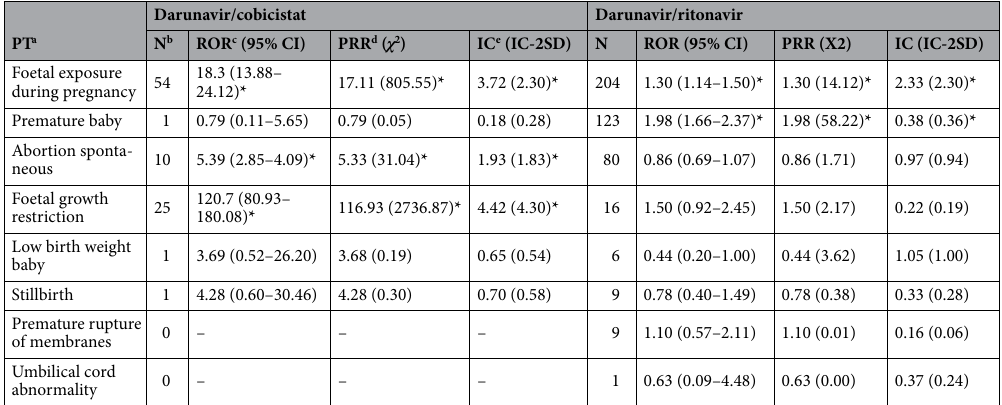
Table 6. Signal strengthof pregnancy, puerperium and perinatal conditions for darunavir/cobicistat and darunavir/ritonavir. a PT: preferred terms. b Number of patients with adverse events. c ROR reporting odds ratio. The lower limits of the 95% CI of the ROR greater than 1 indicated statistically significant RORs. d PRR proportional reporting ratio. PRR and χ 2 greater than 2 and 4 respectively indicated statistically significant PRRs. e Information component. The signal was statistically significant when IC-2SD > 0. * Statistically